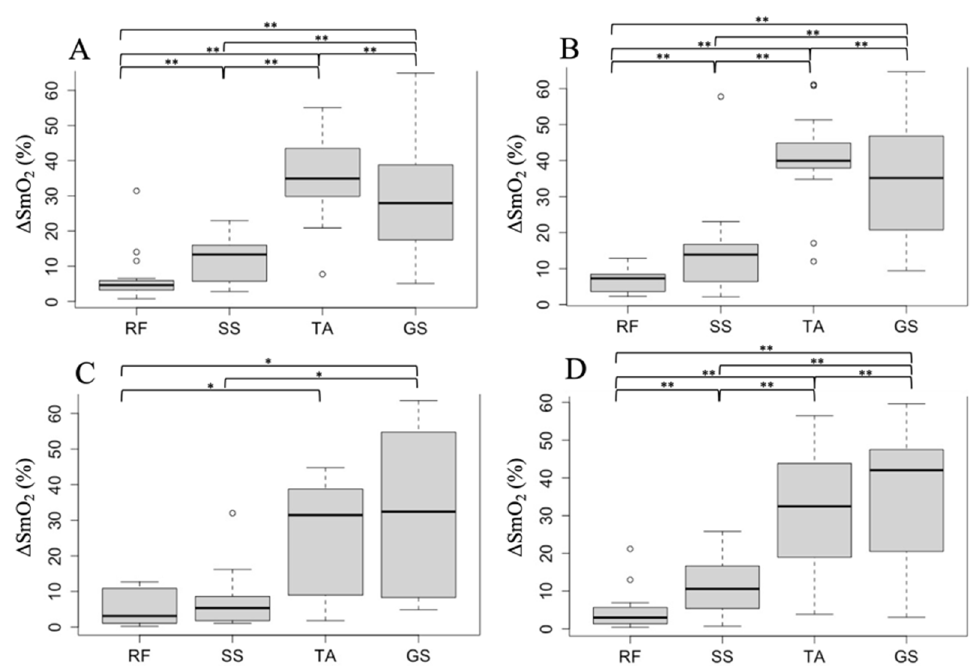
Figure 2. Comparison of the participants’ ∆ SmO 2 in each group. Data were analyzed using the Steel–Dwass test. ( A ) In younger-age (YA) boys, a significant difference was found in the ∆ SmO 2 of all muscles ( p < 0.001). The ∆ SmO 2 of the TA was highest among all the muscles. ( B ) In YA girls, a significant difference was found in the ∆ SmO 2 of all muscles ( p < 0.001). The ∆ SmO 2 of the TA was highest among all the muscles. ( C ) In older-age (OA) boys, ∆ SmO 2 was significantly larger in the TA and GS than in the RF, and ∆ SmO 2 was significantly larger in the GS than in the SS ( p < 0.05). No significant difference was found in ∆ SmO 2 between the TA and GS. ( D ) In girls with OA, a significant difference was found in the ∆ SmO 2 of all muscles ( p < 0.001). The ∆ SmO 2 of GS was highest among all the muscles. An asterisk (*) indicates a statistically significant ( p < 0.05), and double asterisks (**) indicate a statistically significant ( p < 0.001).